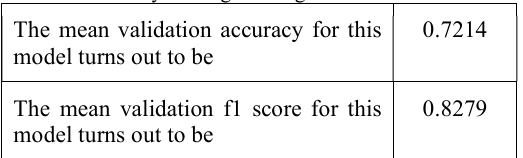
Table 1. Accuracy for Logistic Regression model The mean validation accuracy for this